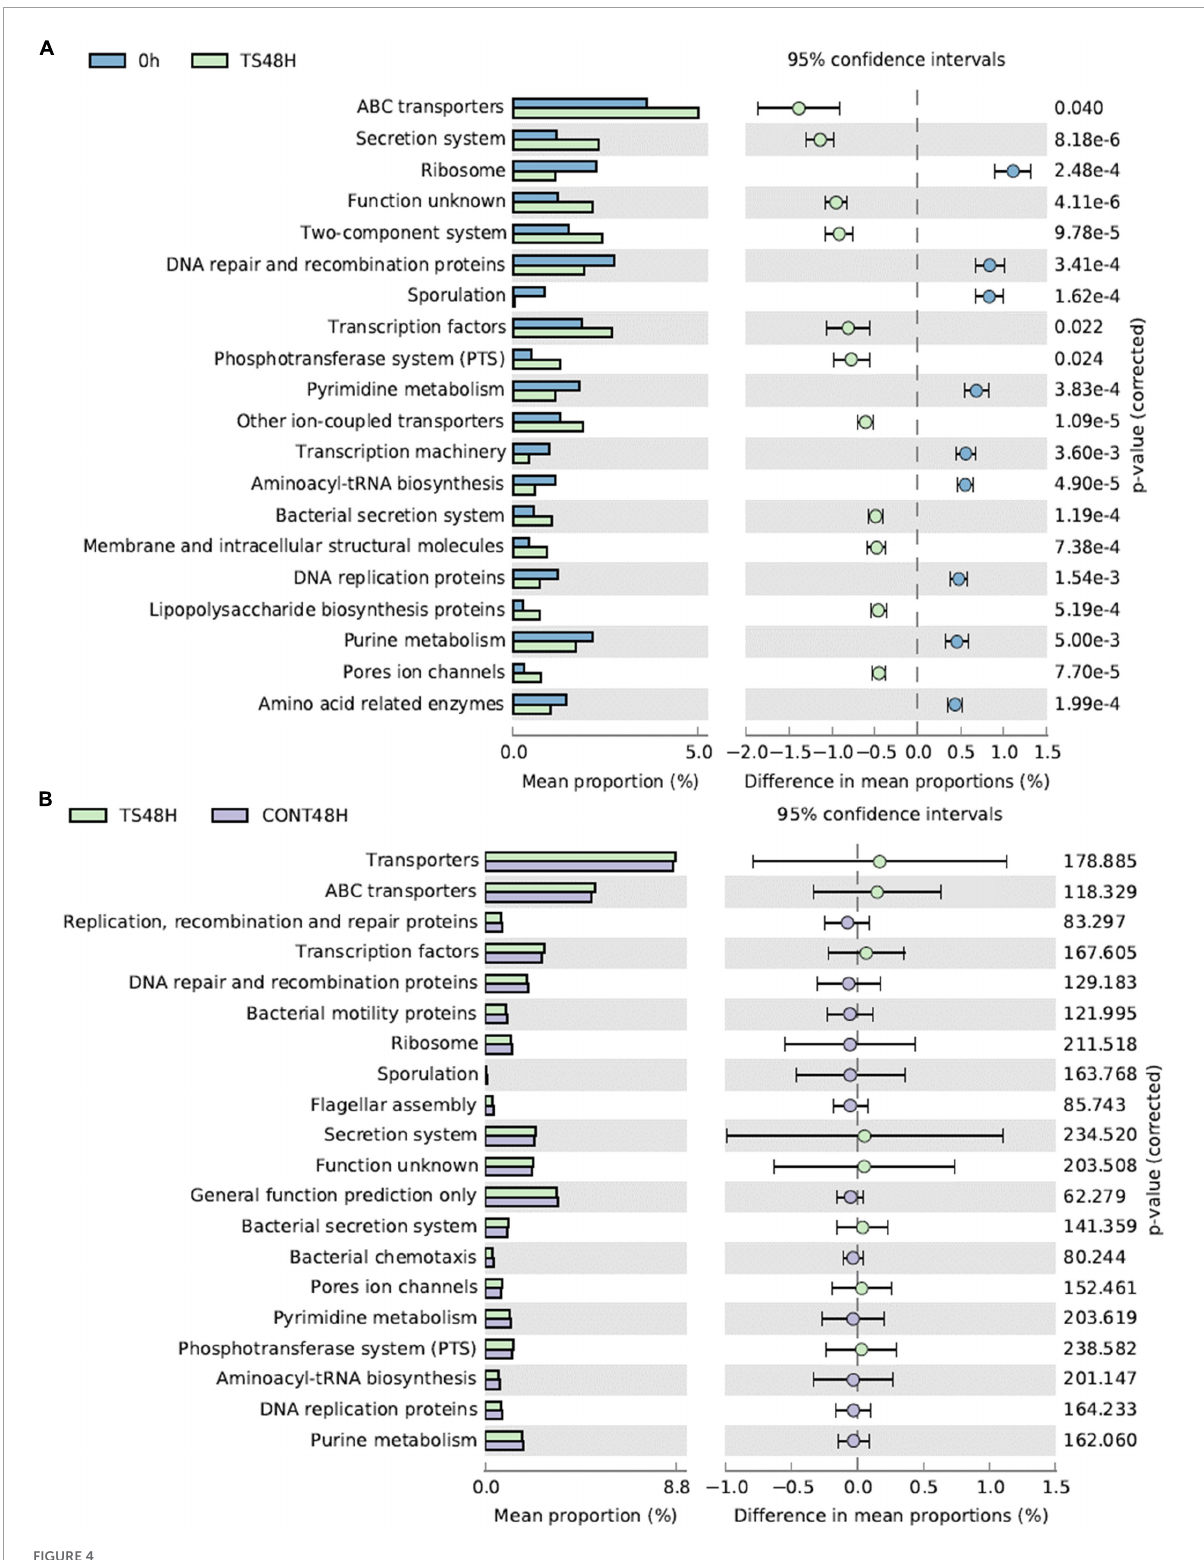
Frontiers in Nutrition